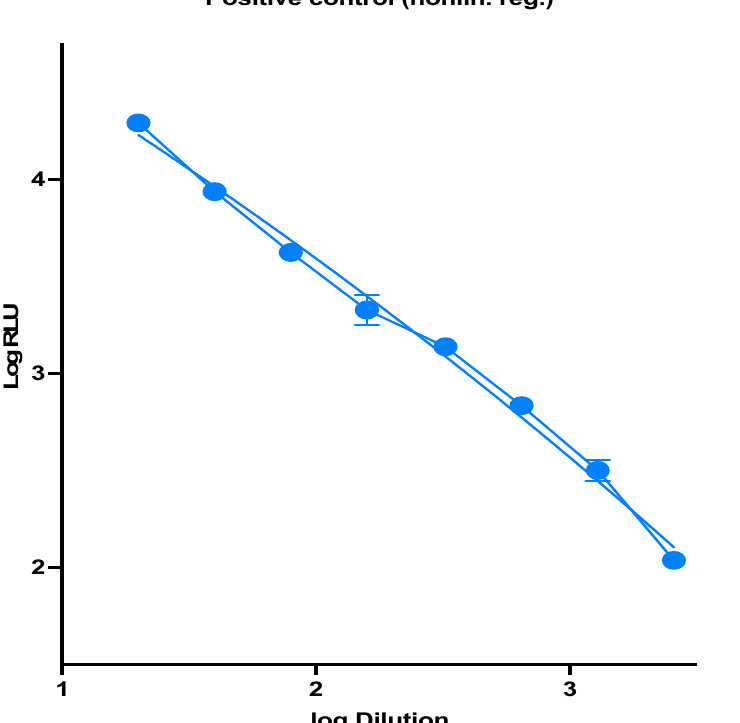
Figure 1. RLU values observed at each serial dilution, virus dilution vs. RLU readout was plotted to select the needed amount of virus.